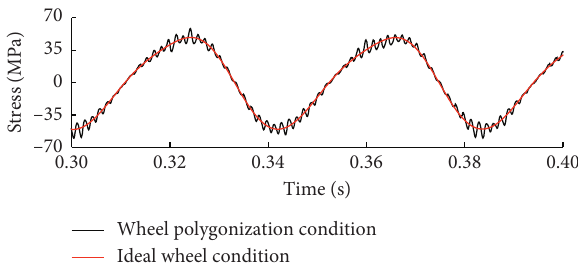
Figure 11: Comparison between polygonal wheels and ideal